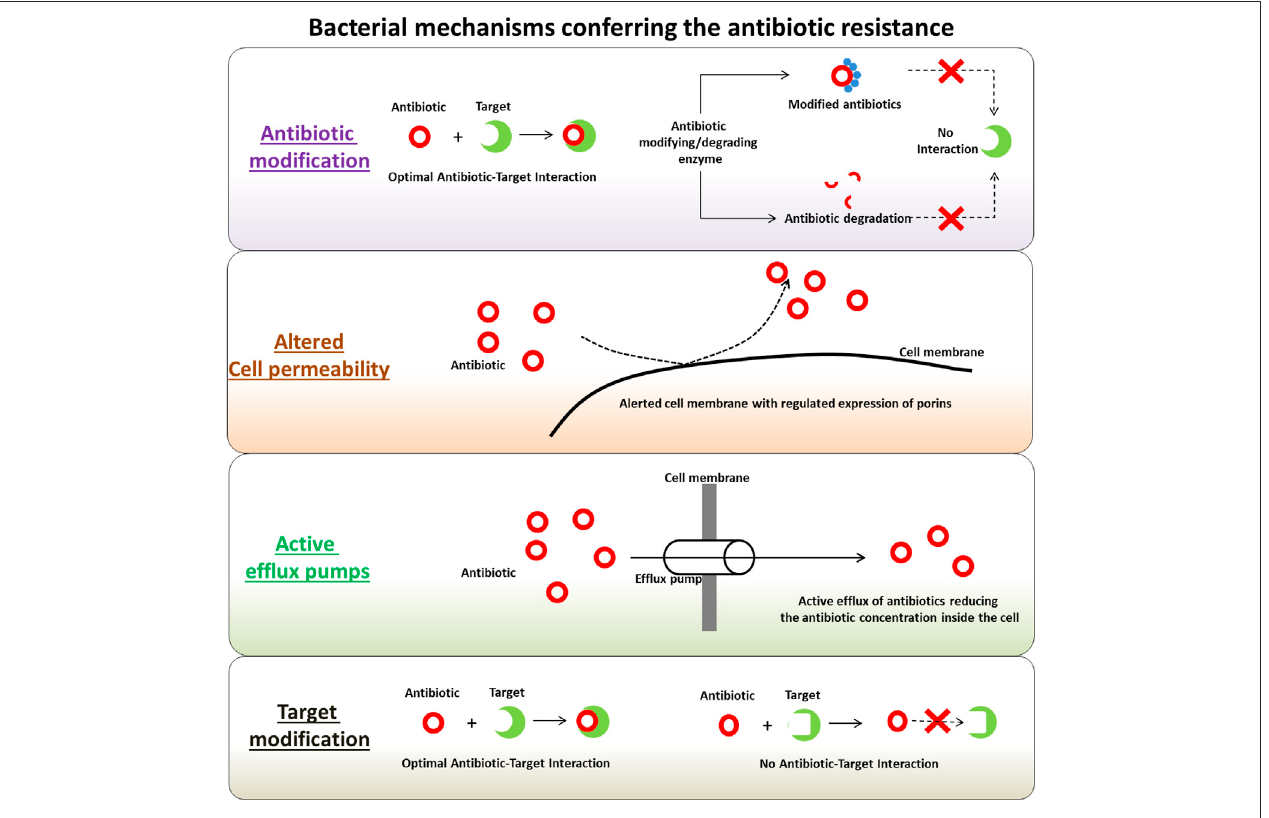
FIGURE 1 | Summary of bacterial mechanisms conferring the antibiotic resistance.